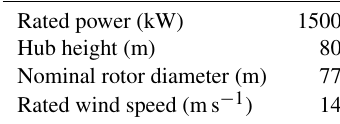
Table 1. Test turbine details. Table 2. Meteorological tower instrumentation